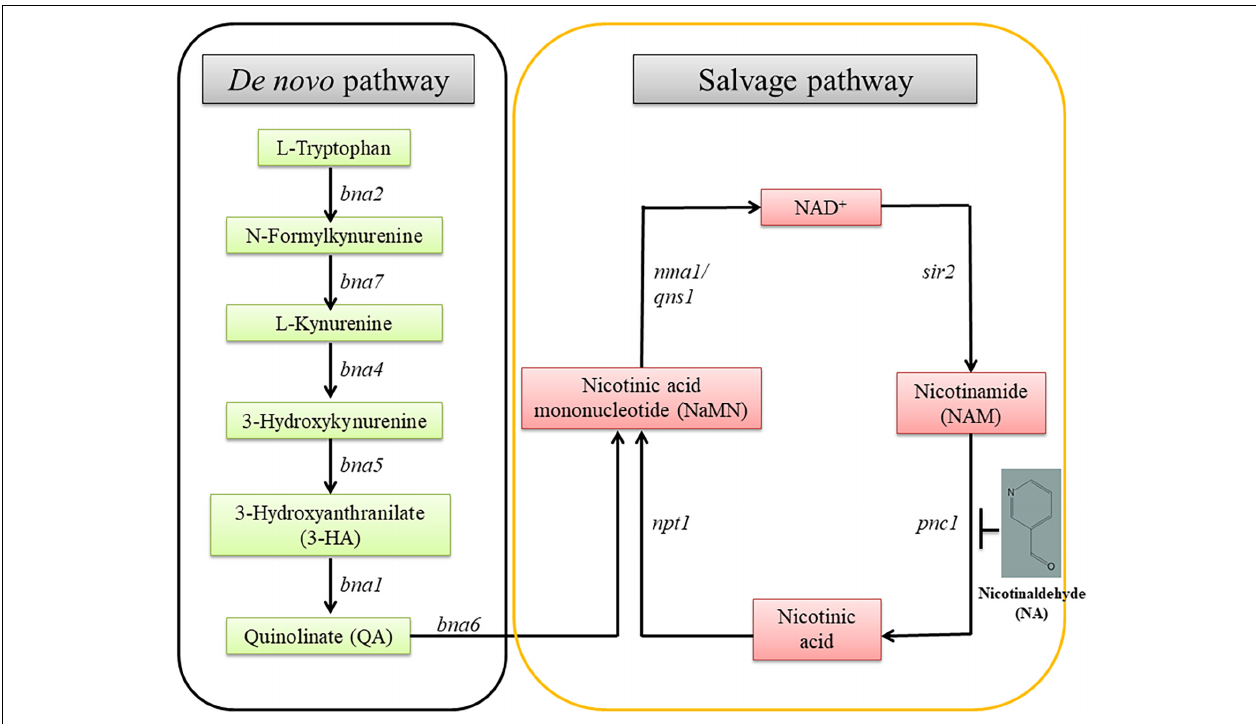
FIGURE 1 | The NAD + biosynthetic pathway. There are two NAD + biosynthesis pathways; de novo and salvage. The starting point of the former is tryptophan; the latter, nicotinamide. bna , biosynthesis of nicotininc acid; namn , nicotinic acid mononucleotide; pnc1 , pyridine nucleotide cycle 1; sir2 , silent information regulator-2; npt1 , nicotinate phosphoribosyl transferase 1; nma1 , nicotinic acid mononucleotide adenyl transferase 1; qns1 , NAD +